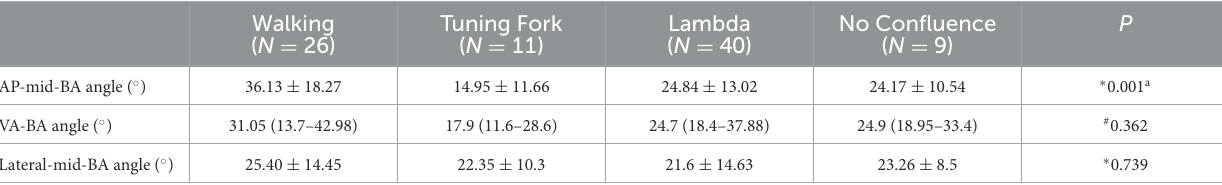
TABLE 5 Comparisons of angle in the four geometric configurations.